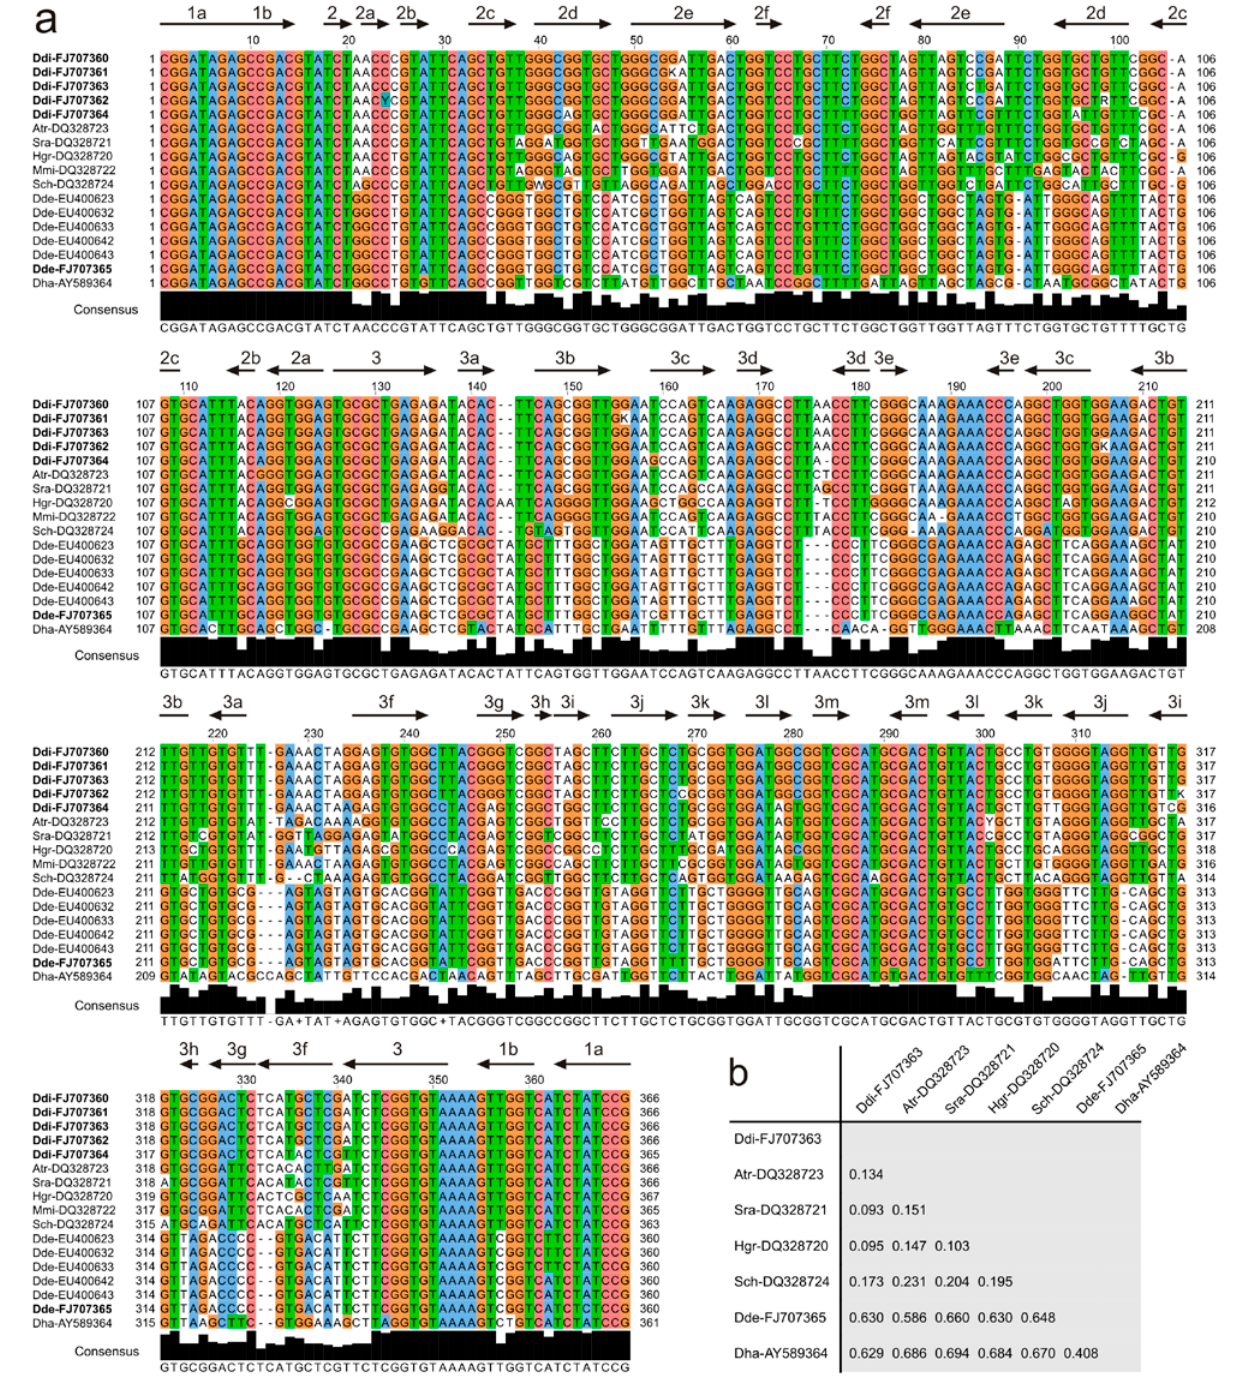
Figure 2. a. Multiple sequence alignment of the expansion segment D2 LSU 28S nuclear rRNA gene from anguinid taxa. The label on the left-hand side of each sequence gives its study code with GenBank accession. The consensus row at the bottom shows the most frequent residue at each row or “+” if two or more residues are equally abundant. Predicted secondary structural elements (helical regions) for the stem nematode Ditylenchus dipsaci are indicated by black arrows ( → or ← ) reported above the sequences; the numbering of helices is the same as in Figure 5a. b. Distance matrix based on the D2-28S rDNA alignment for the selected members of the Anguinidae family. Note: For each matrix, the values are pair-wise p-distances, which represent the divergence of all bases between two sequences. Nematode species abbreviations: Ddi, D. dipsaci ; Dde, D. destructor ; Dha, D. halictus ; Atr, Anguina tritici ; Sra, Subanguina radicicola ; Hgr, Heteroanguina graminophila ; Mmi, Mesoanguina millefolii . The number following species abbreviation at each nucleotide sequence represents GenBank accession